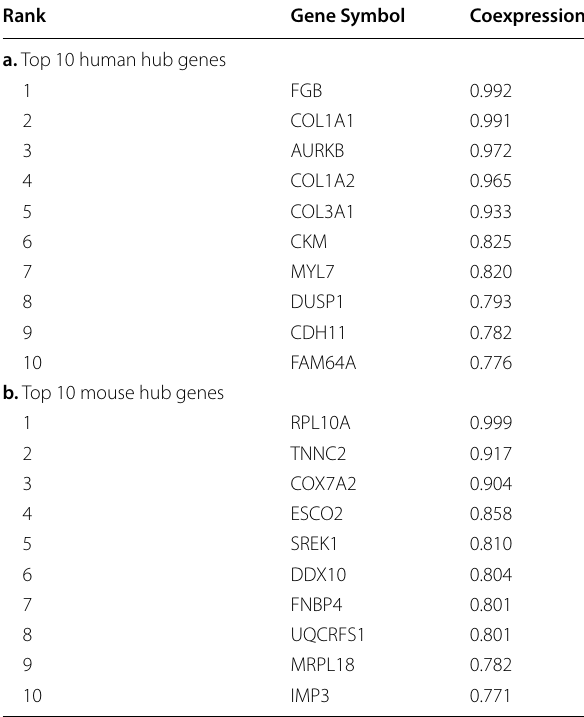
Table 3 Top 10 most significantly up-regulated genes (Hub Genes) from the PPI Networks of a) human or b) mouse data sets Rank Gene